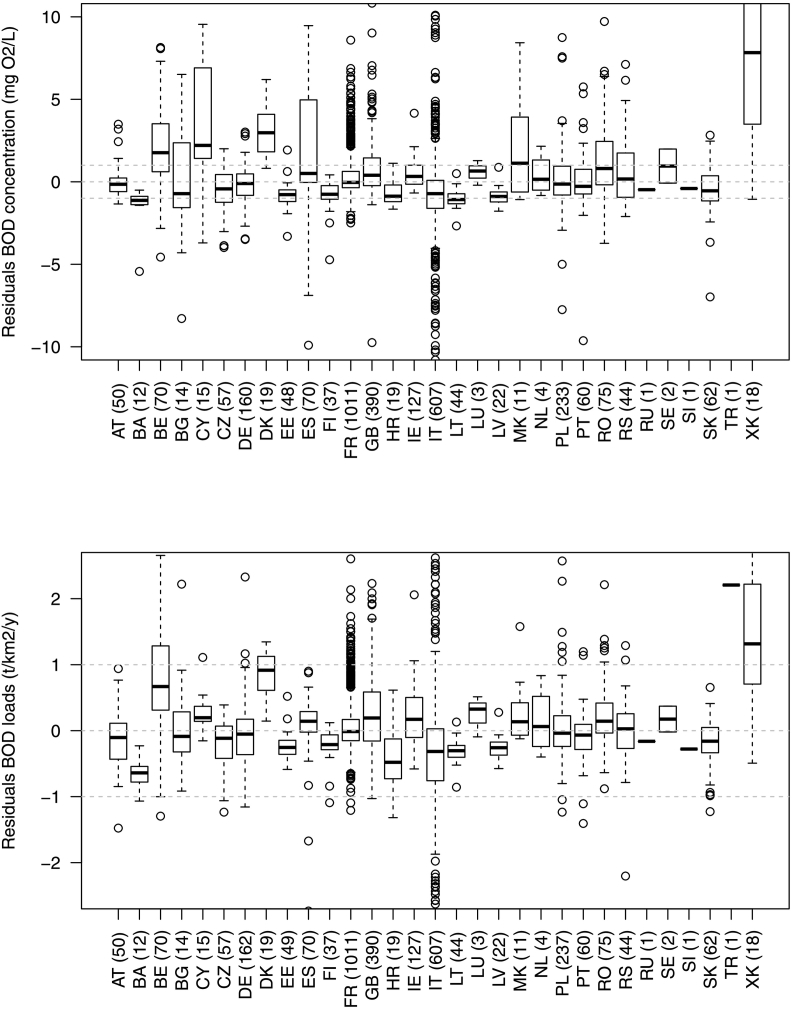
Model residuals (predicted-observed) BOD fluxes (concentrations and specific loads) per country. Number in brackets indicate the number of stations per country. Dashed grey horizontal lines indicate null and ±1 errors. Country codes are defined in Supplementary material S1.